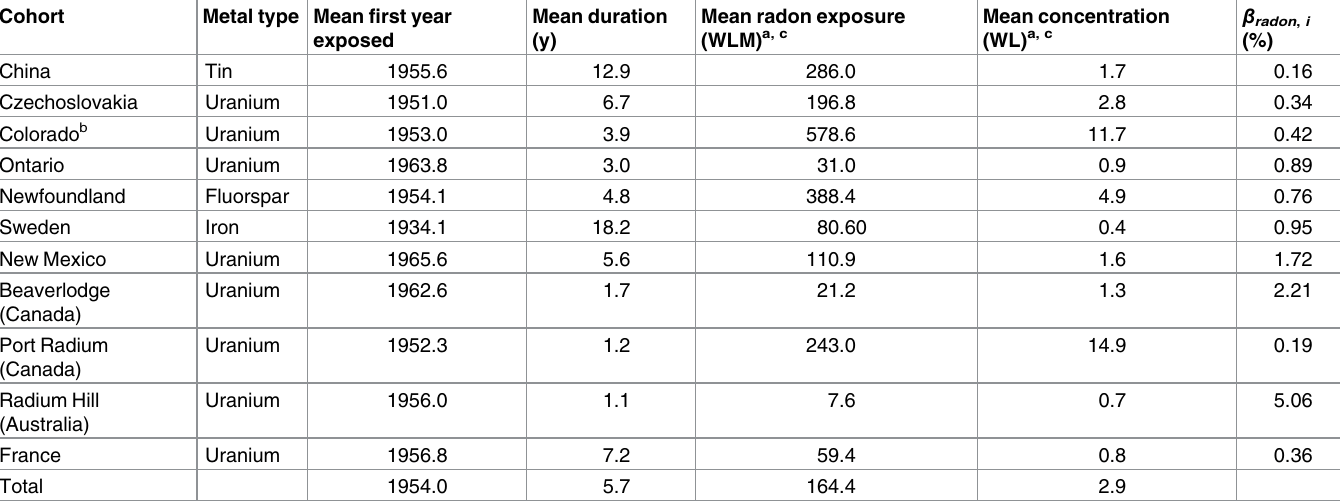
Table 1. Summaryinformation of the radon exposures in the 11 miner cohort